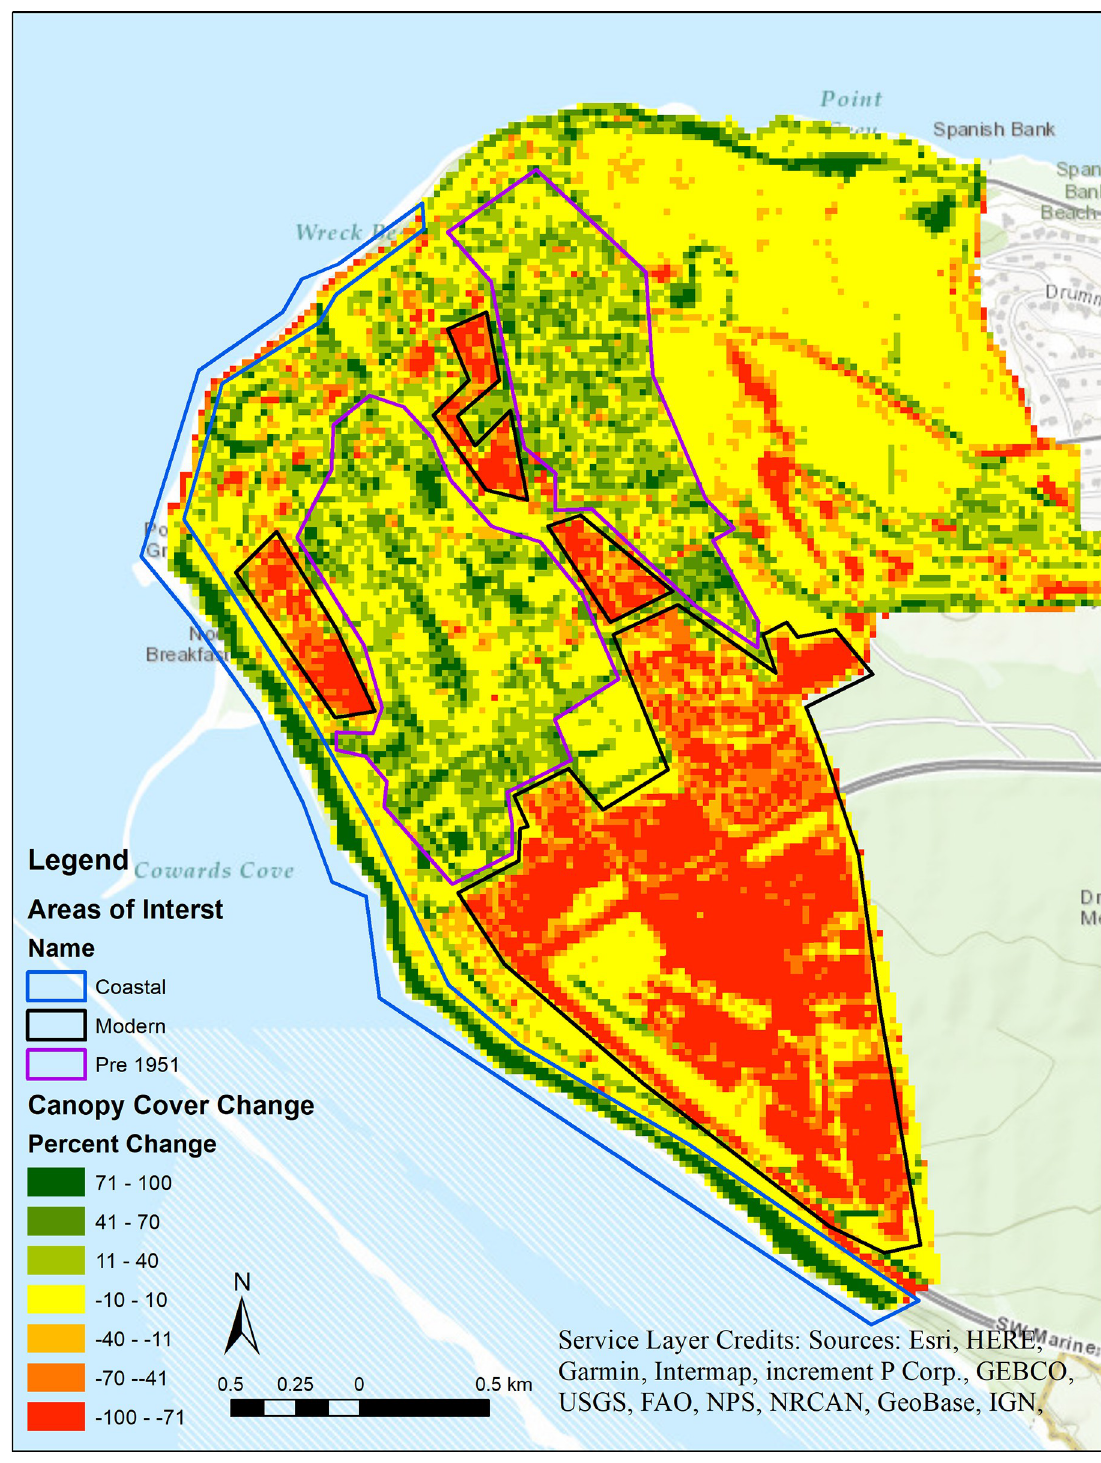
Fig 4. Map showing the differences in forest cover at UBC’s campus between 1949 and 2015. Red indicates canopy reduction and green indicates an increase in canopy cover. The blue outline denotes the coastal area, black is the post 1949 (or modern) development and purple is the pre-1949 development area. Base map layer credit: Esri, HERE, Garmin, Intermap, increment P Corp., Gebco, USGS, FAO, NPS, NRCAN, GeoBase, ING (ArcGIS Licence 10.8.1).